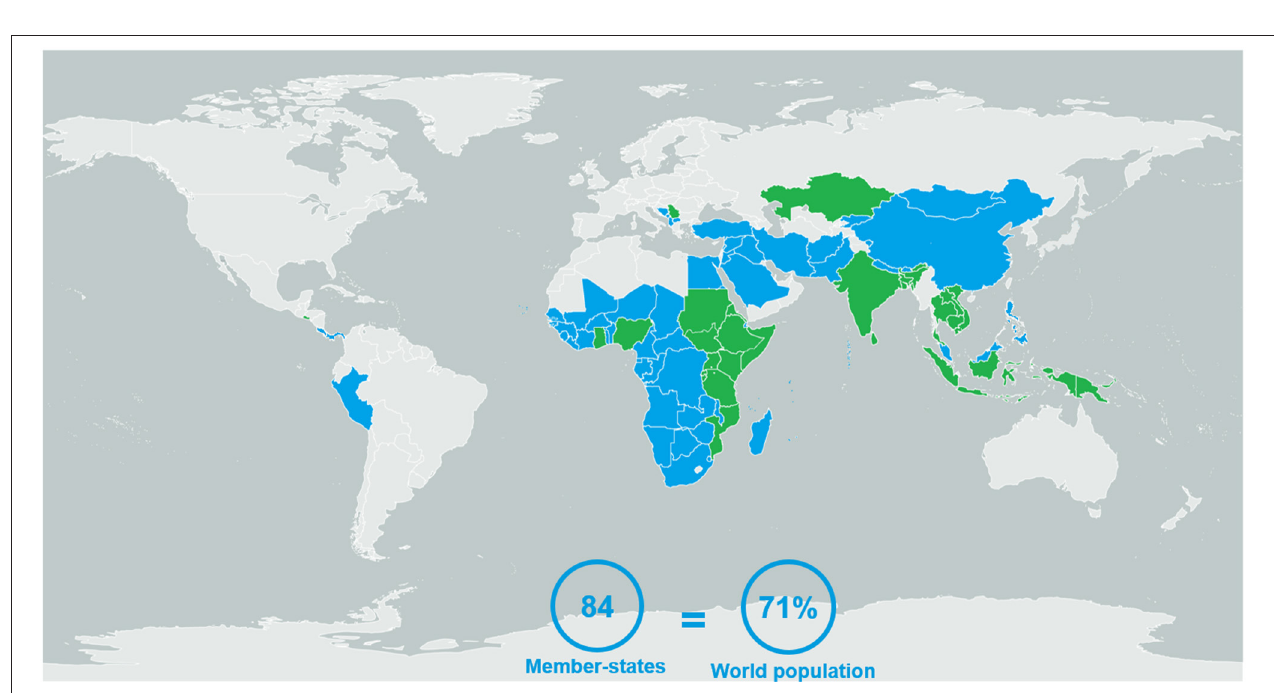
FIGURE 1 | The 84 Member States evaluated using the WHO’s Global Benchmarking Tool between 2016 and 2020, either via self- ( blue ) or formal ( green ) benchmarking.